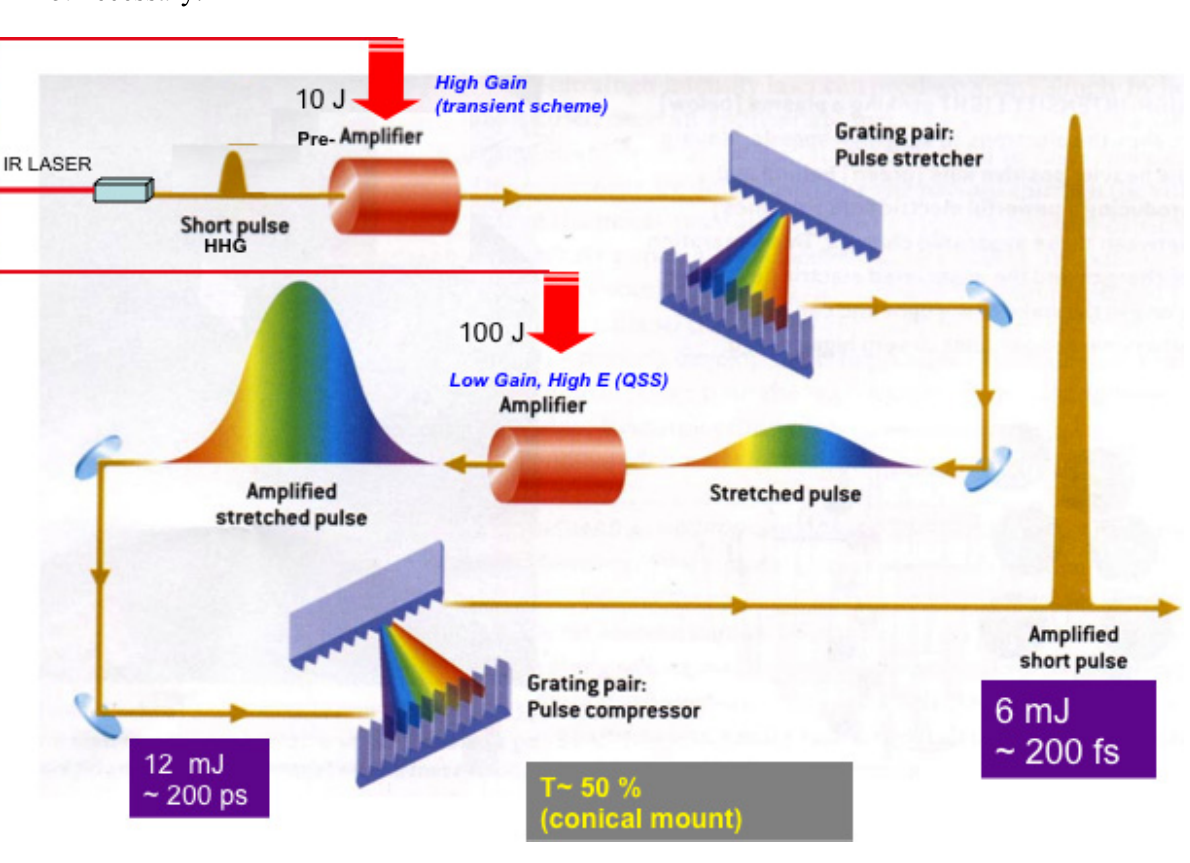
Figure 7. Schematic description of a high energy X-ray Chirped Pulse Amplification (CPA) chain. The same laser is split into three beams to generate the HHG, to pump the pre-amplifier using the Transient Collisional Excitation Scheme (TCE) scheme and to pump the main amplifier with ns duration. Note that the stretcher is placed after the pre-amplifier to keep the intensity high enough for efficiently seeding the different plasmas. This scheme is fully scalable to higher or lower energies. In that last case, pre-amplifier is not